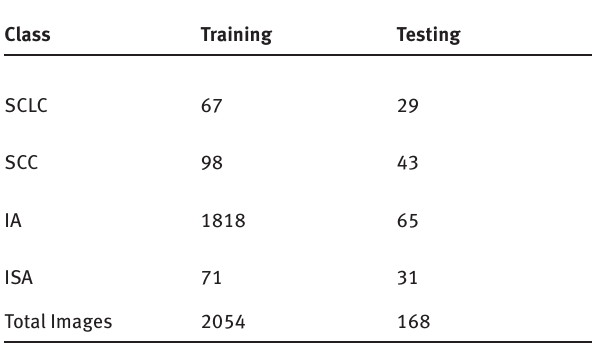
Table 2: The data-based image for training and